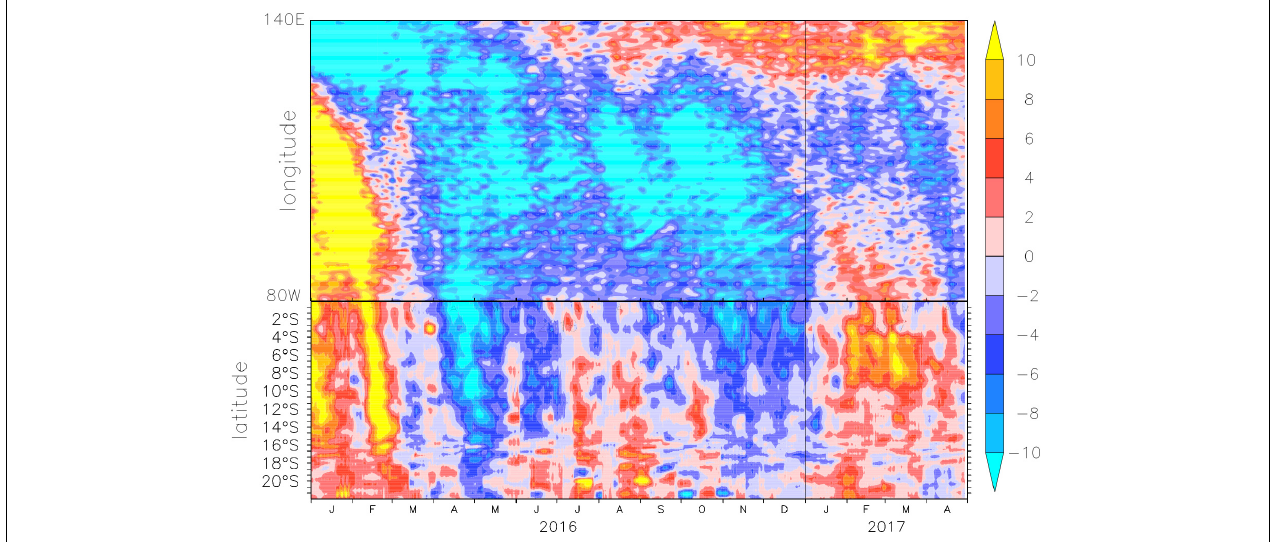
FIGURE 3 | Hovmöller of altimetric sea level anomaly (in cm) along the equator (140 ◦ E–80 ◦ W) and along the coast of Peru (0–22 ◦ S). The sea level anomalies were computed using the 1/4 ◦ × 1/4 ◦ gridded product, such that for each latitude, the sea level observations were averaged between the coast and 50 km offshore. The anomalies were computed with respect to a 2013–2016